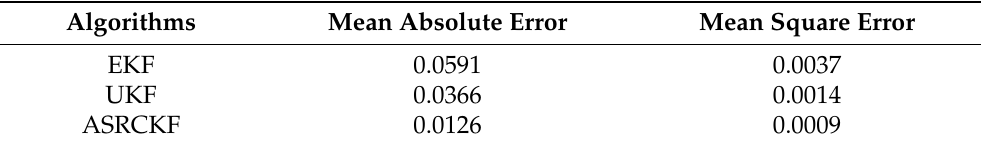
Table 4. Comparison of fault estimation performance.